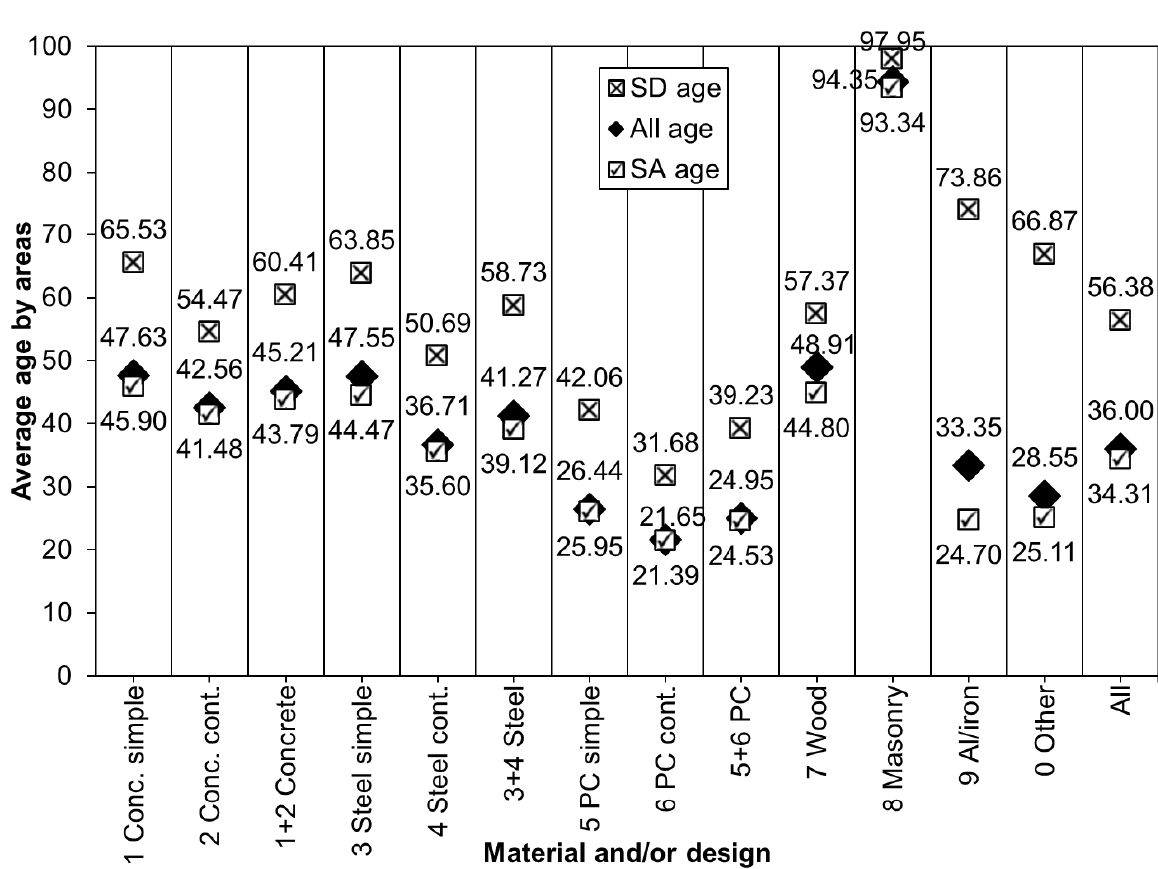
Figure 8. Average area ages of bridge materials and/or designs.